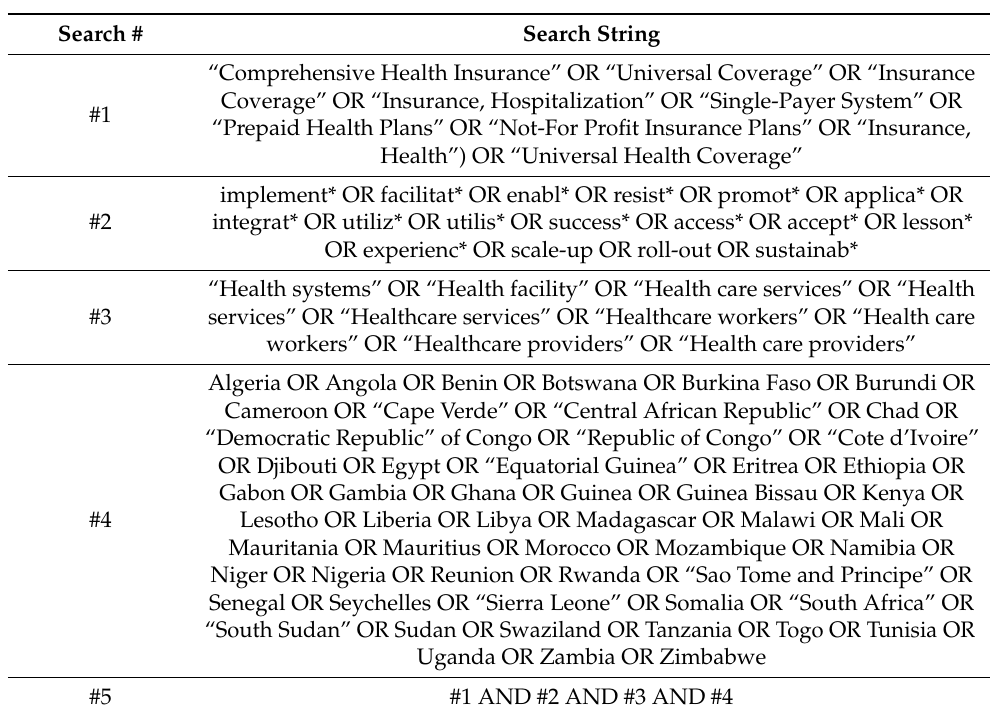
Table 2. PubMed and Scopus search